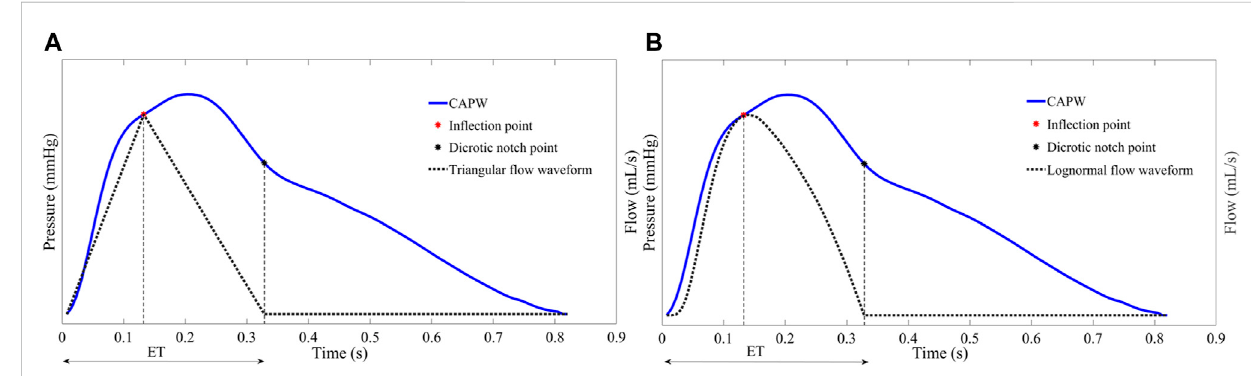
FIGURE 6 (A) The start, peak, and end of the triangle fl ow waveform correspond in time and amplitude to the foot, in fl ection point, and dicrotic notch point of the CAPW, respectively (B) Lognormal function approximation fl ow